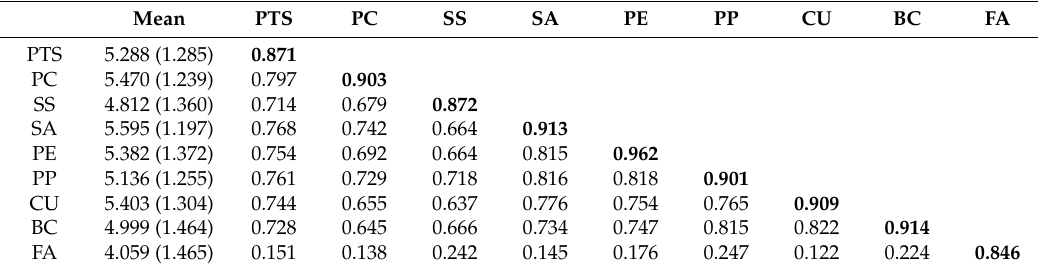
Table 4. Descriptive statistics and correlation matrix.